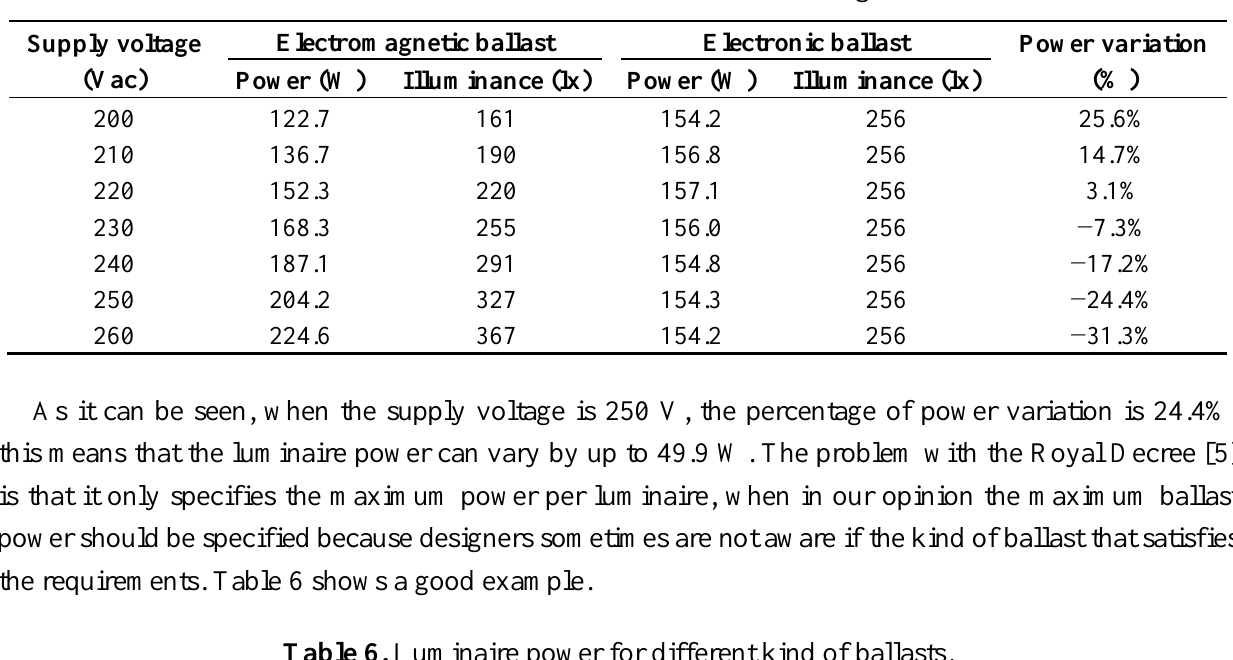
Table 5. Power variation between electronic and electromagnetic ballasts [33].